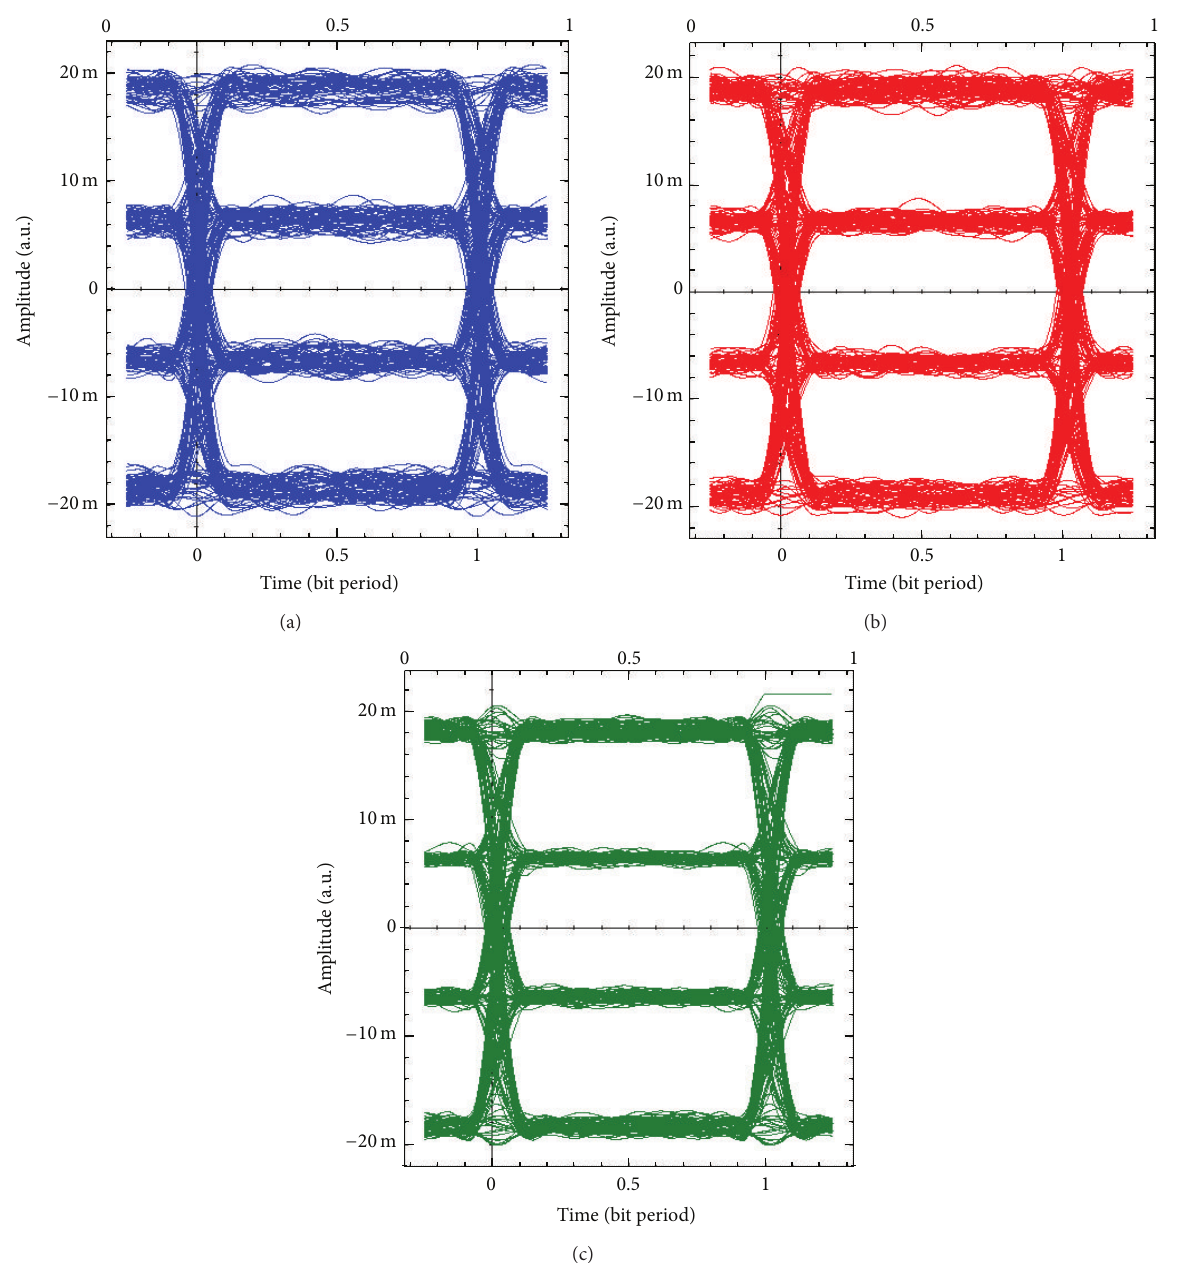
Figure 10: Eye diagrams of the 𝐼 -branch of the demodulated 16 QAM baseband signals for (a) MIMO 1 , (b) MIMO 2 , and (c) MIMO 3 .